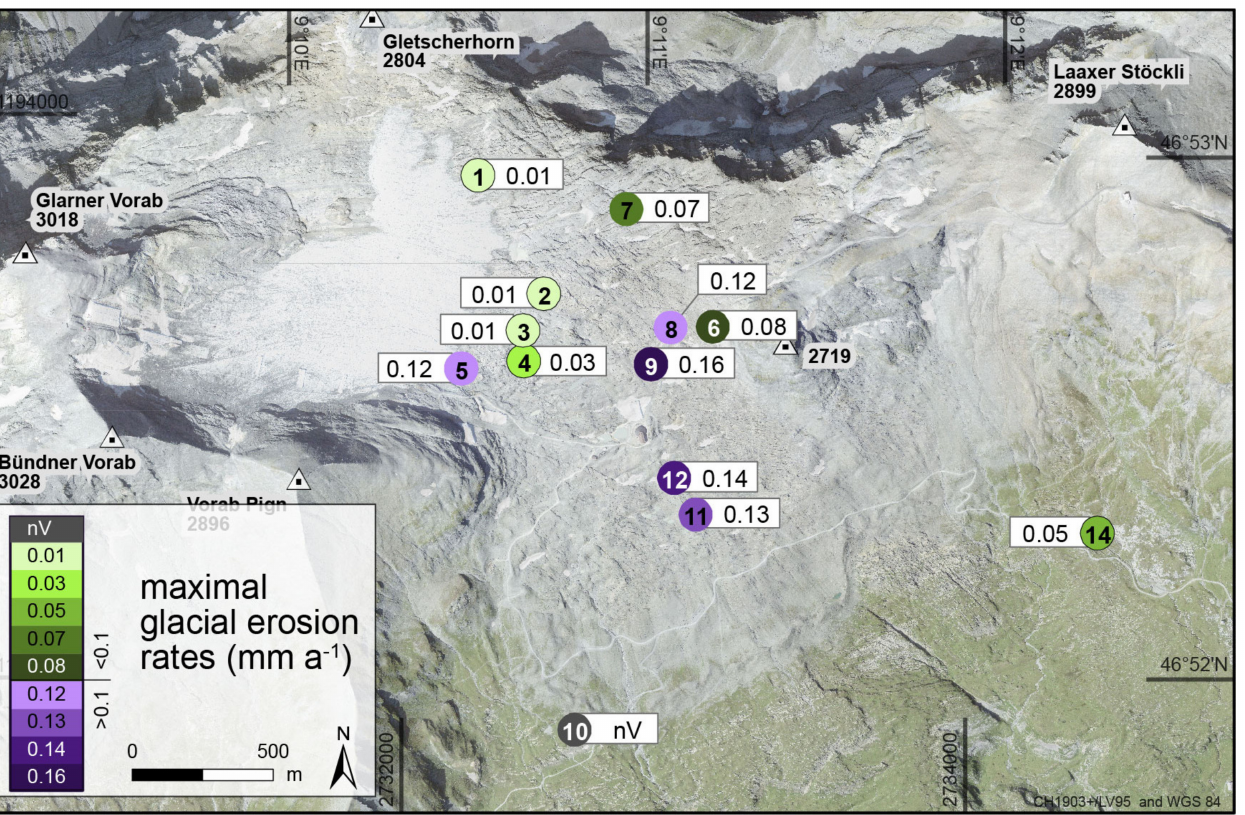
Figure 9. Determined maximal glacial erosion rates given in mm a − 1 (Table 3). Green colours indicate glacial erosion rates less than and violet colours more than 0.1 mm a − 1 . 3D view created with the swissIMAGE orthophoto 2019 and the SwissALTI3D 2019 (reproduced with authorization of the Swiss Federal Office of Topography,